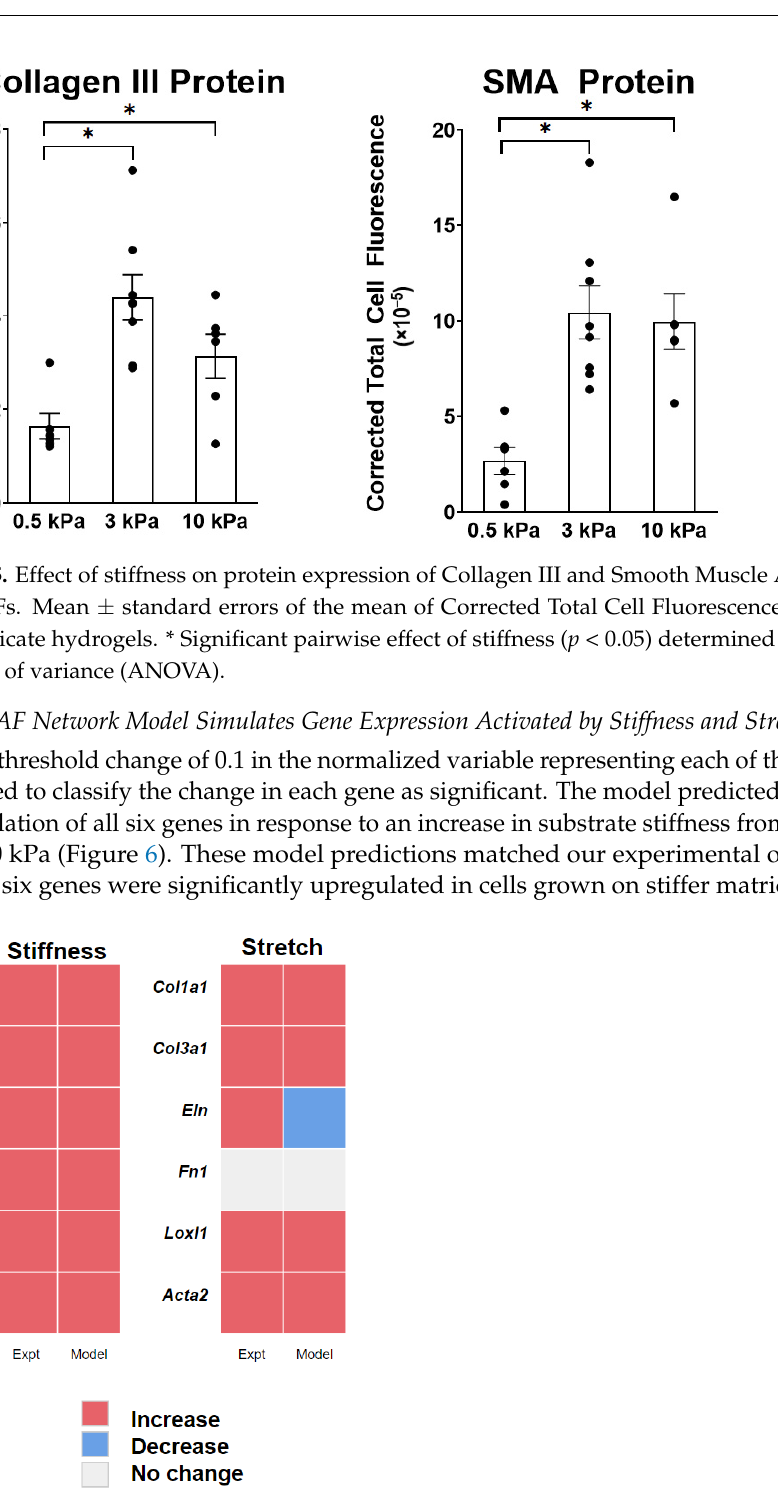
Figure 6. Comparison of the experimental observations (Expt) with model predictions (Model) of gene activity due to stretch and stiffness. Increase (red), decrease (blue), and no change (grey) in gene expression predicted by the model is based on a threshold of 0.1 and experimental observations that reached a significant difference 24 h after stretch ( p < 0.05).